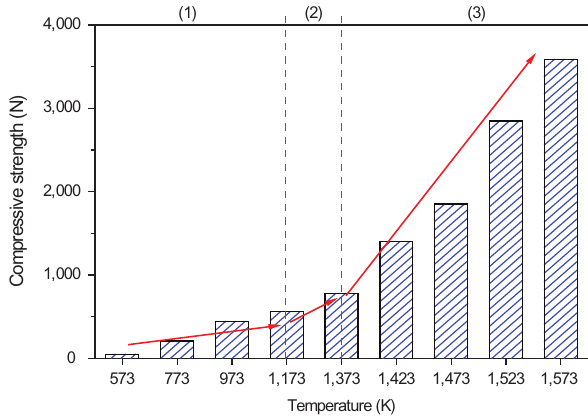
Figure 3: TG-DSC curve of HCVTM.